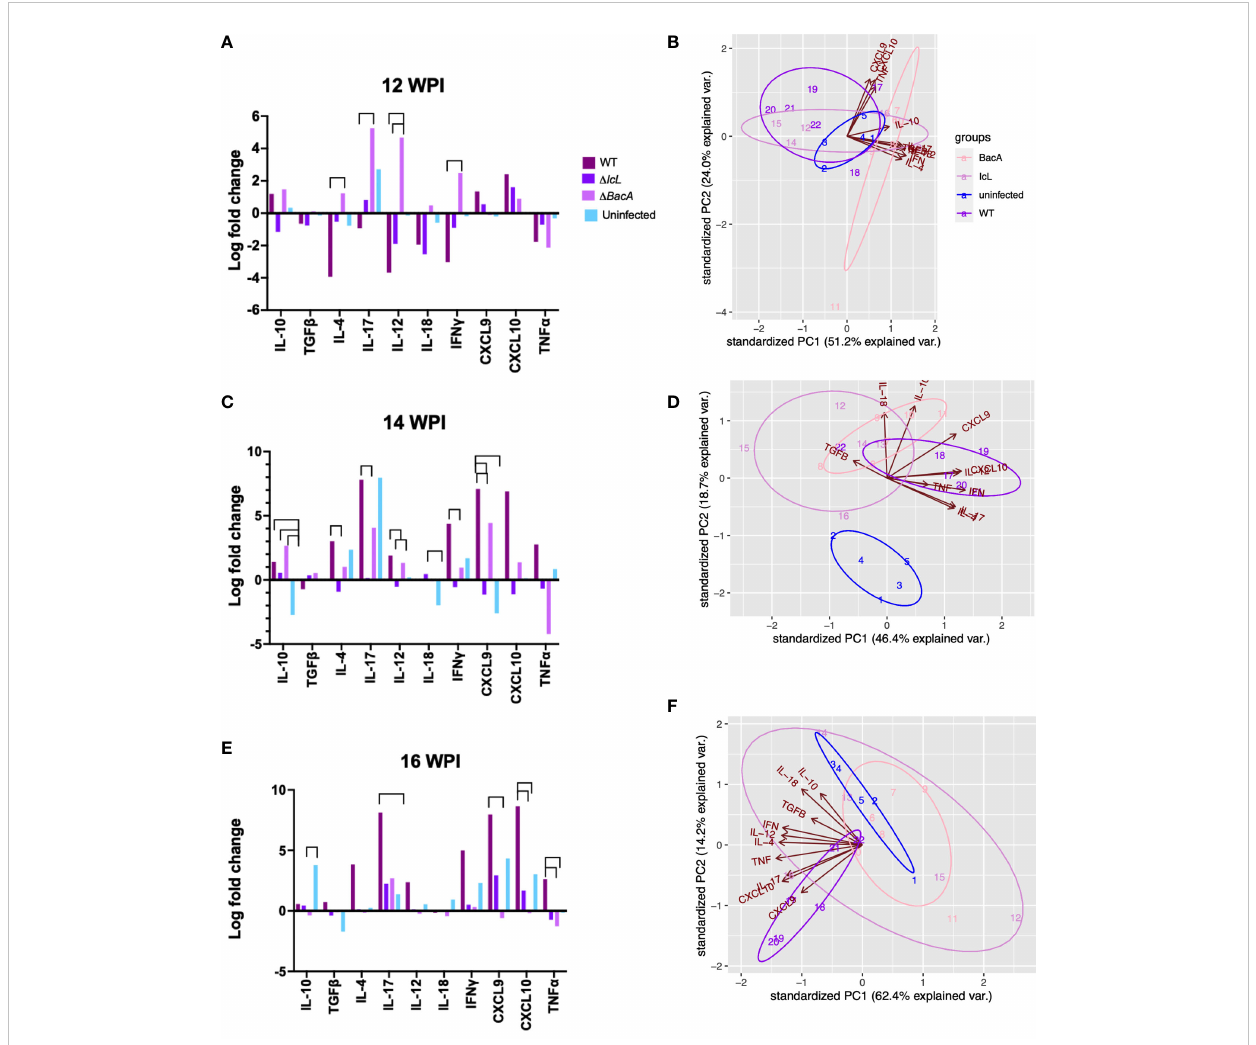
FIGURE 7 Cytokine expression analysis by RT-PCR, comparing groups at different timepoints. PBMCs were isolated from different groups (Uninfected =5, BacA=6, IcL=6, and wild-type=6). After 24 hours of in vitro stimulation with PPDa, RNA was extracted from PBMCs and reverse transcribed. RT-PCR was performed on cDNA, using 18s rRNA as a housekeeping gene and unstimulated samples as a calibrator. The data was analyzed by DD ct and the difference among groups were assessed by one-way ANOVA and then further validated by Tukey-Kramer test. (B, D, F) Groups are color coded and numbers indicate animal IDs. Each group is clustered with a different ellipse. The vectors of the loading plots showing how strongly each variable in fl uence a principal component, with their directions indicating how different variables are correlated with one another. The smaller the angel between two vectors, the more positively correlated they are. If they diverge and form a large angel close to 180 degrees, they are negative